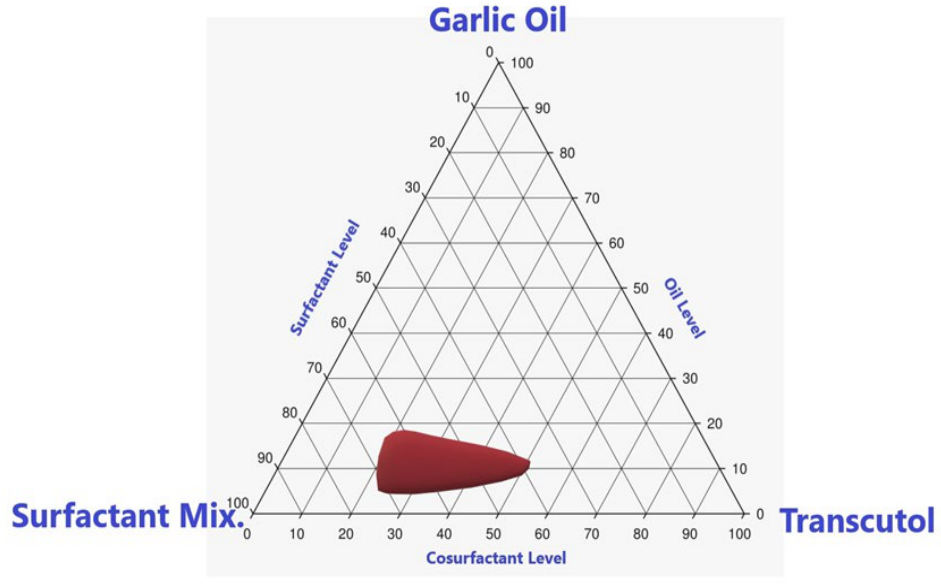
Figure 1. The pseudoternary phase diagram of GO, Smix, and Transcutol co-surfactant.